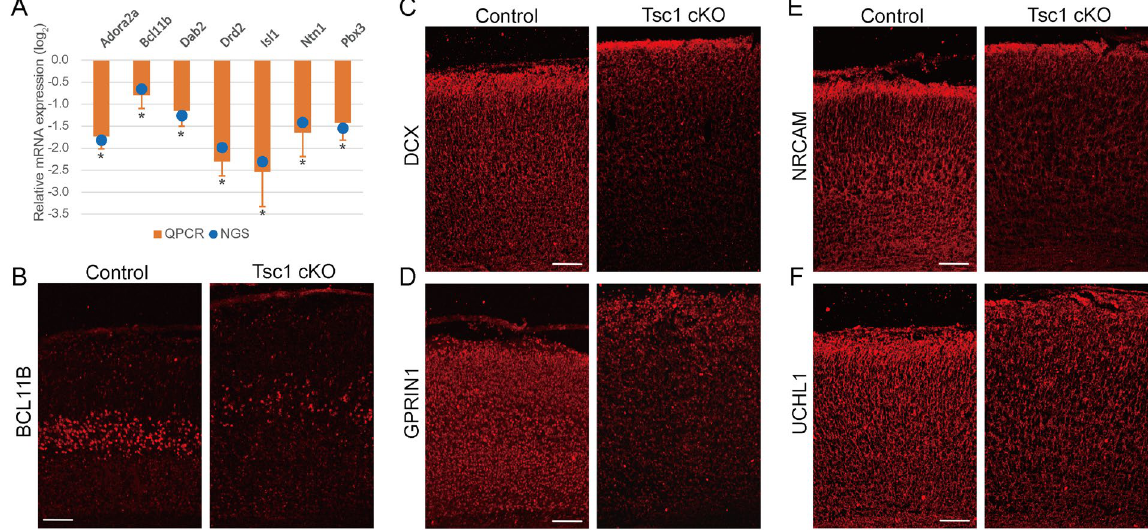
Figure 5. Validation of molecular signatures related to developmental and morphological defects in forebrains. ( A ) Relative mRNA expression levels of seven representative down-regulated genes in TSC1 CKO brain, compared to WT, involved in neuronal morphogenesis and neuronal development are examined using qRT- PCR. * P < 0.05 from Student’s t-test. The blue dots show the expression levels from transcriptomic analysis. ( B – F ) Expression of five representative down-regulated proteins involved in neuronal morphogenesis and neuronal development are examined. The results from immunohistochemical staining using WT and TSC1 CKO cortex at P0 are shown. Scale bar = 100 µ